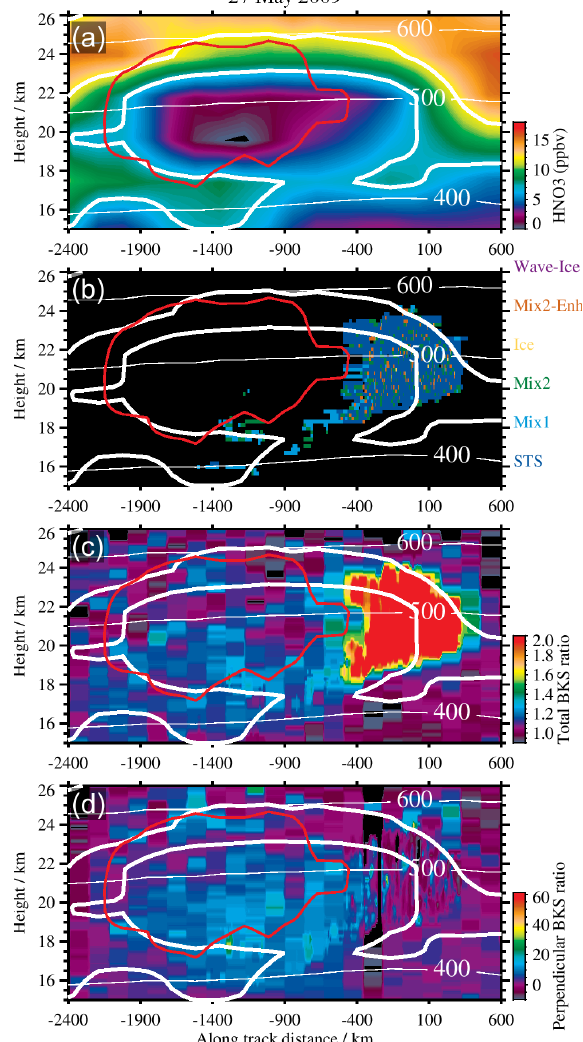
Figure 9. Comparison of along-track data for a partial orbit on 27 May 2009: (a) MLS HNO 3 showing sequestration and the central region of total denitrification. (b) CALIOP PSC Mask does not show a corresponding large-scale detection of MIX1 clouds. (c) Smoothed CALIOP total backscatter ratio. (d) Smoothed CALIOP perpendicular backscatter ratio. Solid thick white contours are the MLS HNO 3 isolines for 7 and 12ppbv HNO 3 . Red contours indicate TTE values ≥ 3 days. The detection of solid particle PSCs is evident in the smoothed CALIOP perpendicular backscatter ratio and extends below the TTE contour by